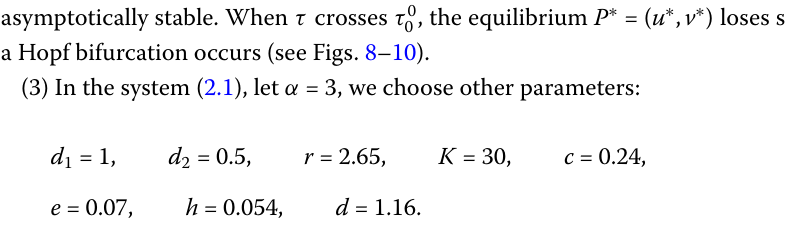
asymptotically stable. When τ crosses τ 0